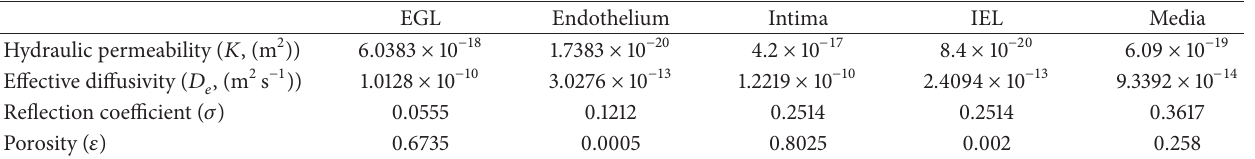
Table 1: Model parameters for each